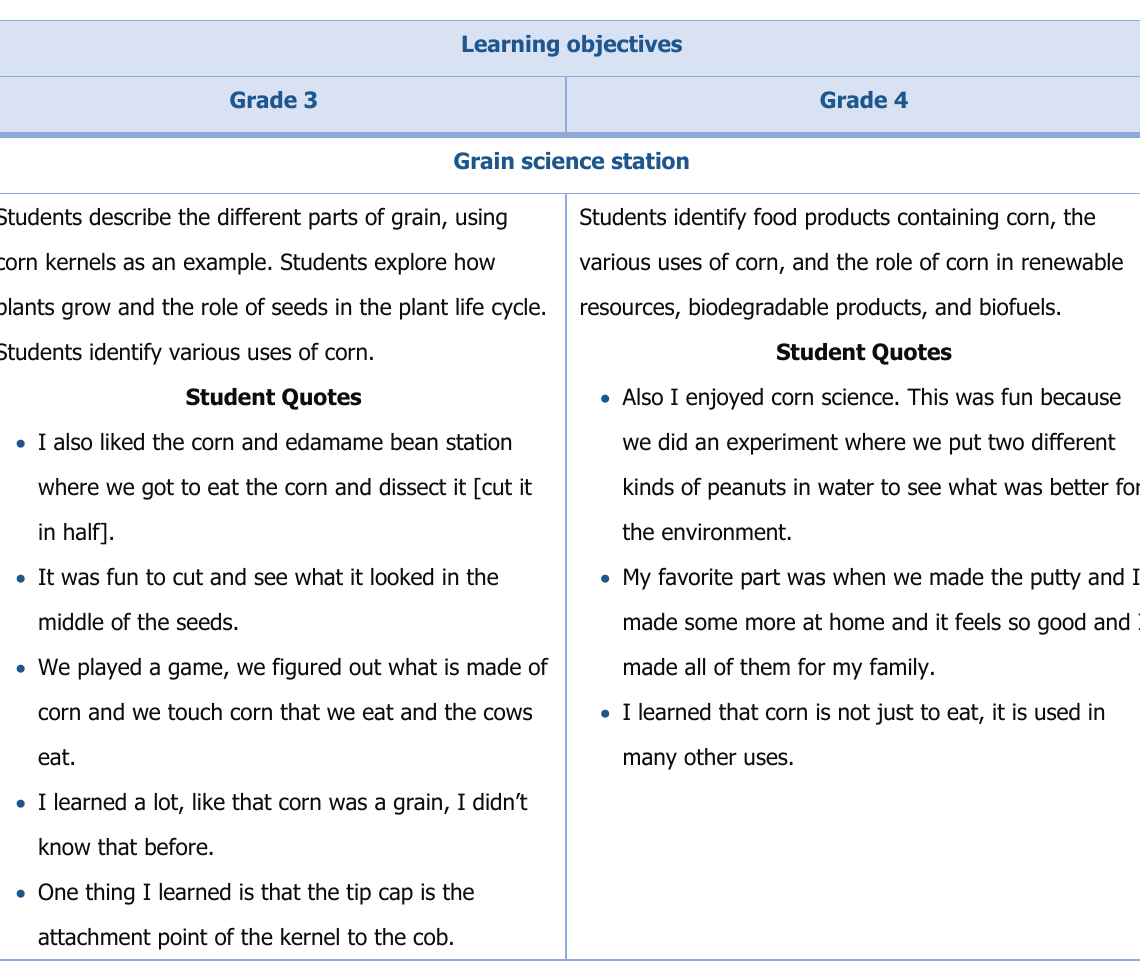
Table 1. Station Learning Objectives by Grade with Supporting Student Thank